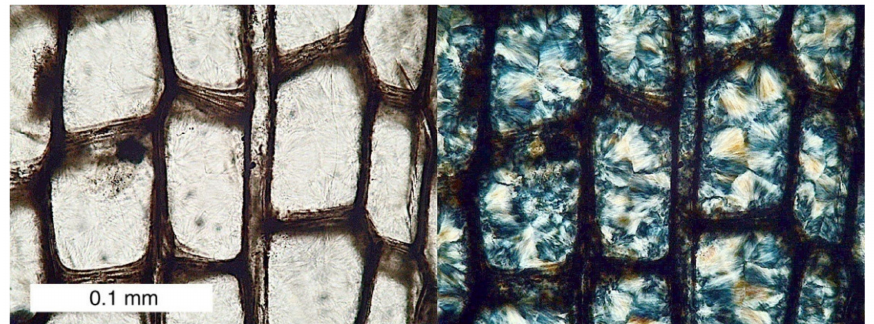
Figure 11. Thin section views of Carboniferous lycopod wood from the southern Rocky Mountains, Colorado, USA [48,49]. Ordinary transmitted light on right. Dark cell walls presumably owe their tint to relict organic matter. Polarized light view ( left ) shows crystalline silica filling cell lumen. Paleobotanists are seldom aware of the mineralization features of fossil wood because of their reliance on biological microscopes for observing cellular